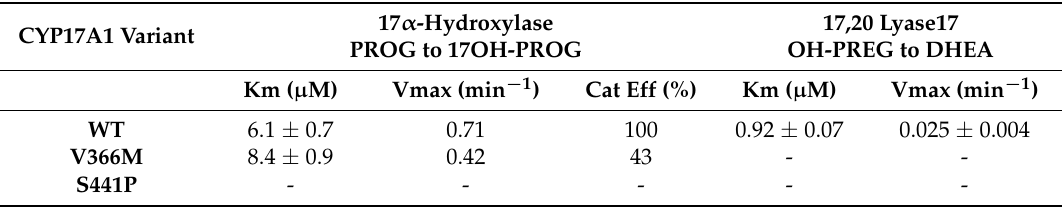
Table 3. Kinetic parameters for the metabolism of PROG to 17OH-PROG (17hydroxylation) and